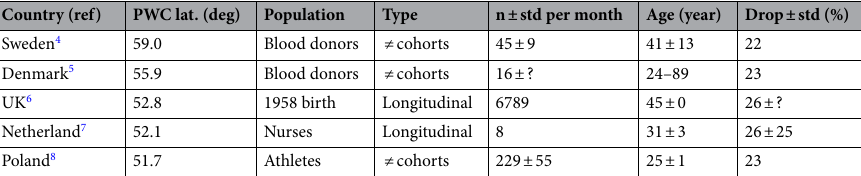
Table 1. Monthly seasonal 25(OH)D concentration studies. Right column: 25(OH)D concentration drop between August and